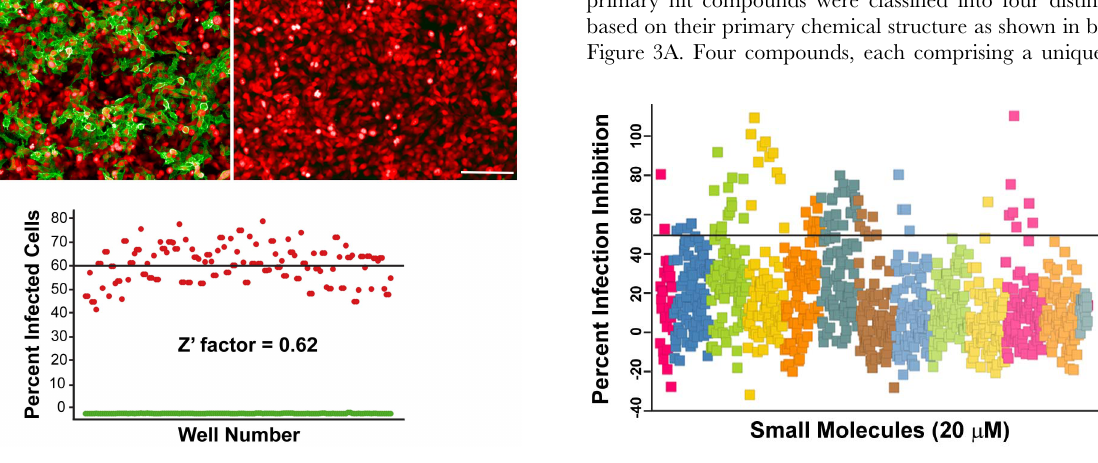
PLOS Neglected Tropical Diseases |